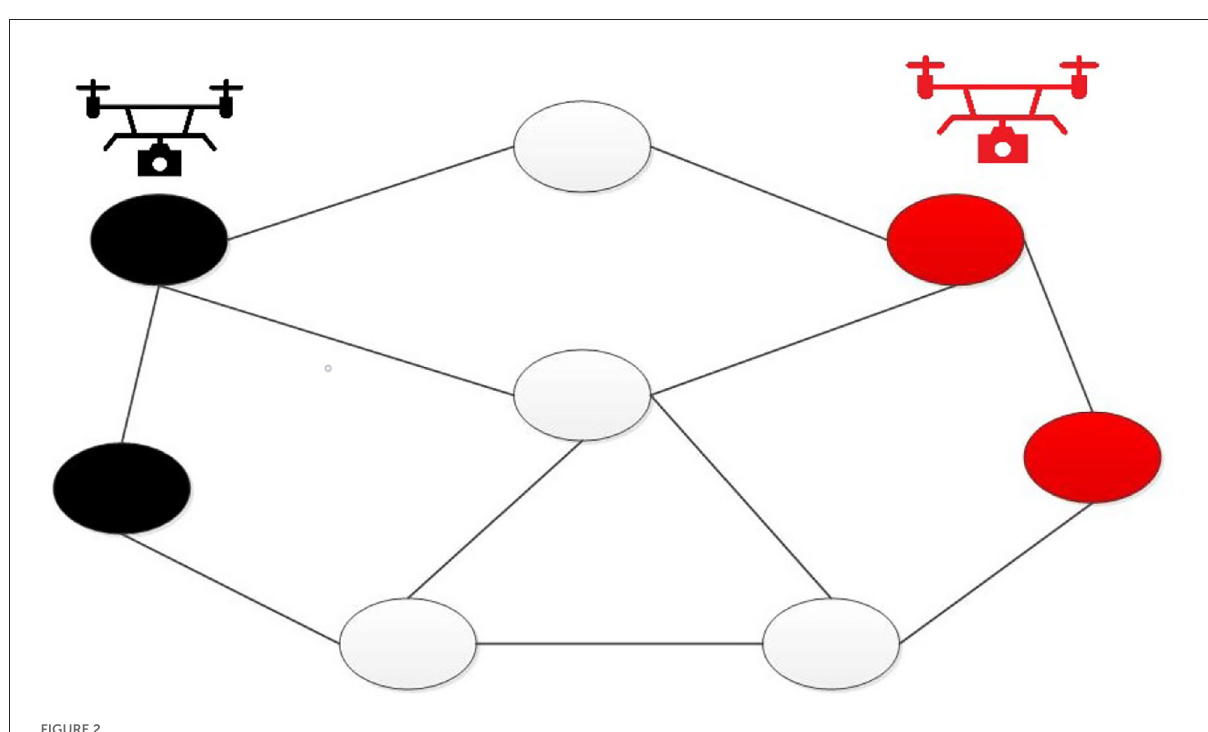
FIGURE2 A route plan for